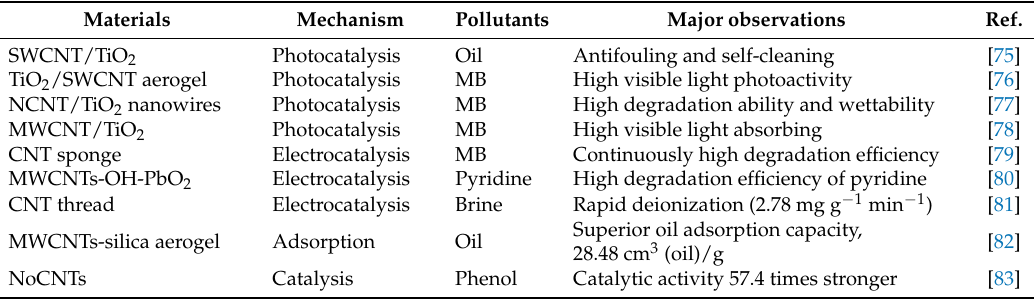
Table 1. CNTs as catalyst support for water